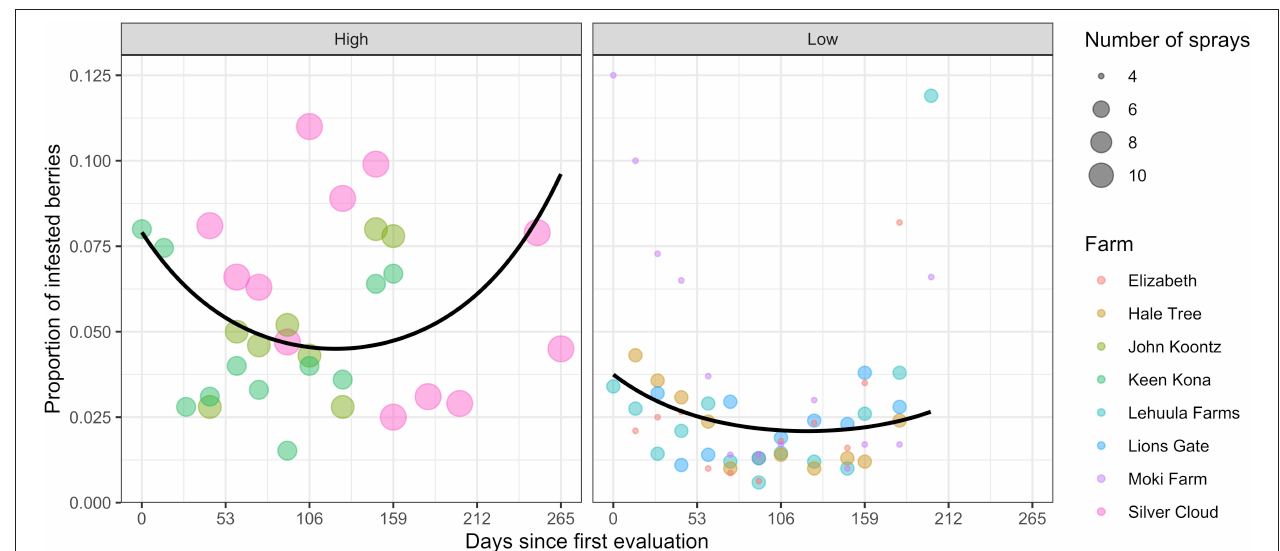
FIGURE 3 | Proportion of CBB-infested berries from eight coffee farms in the Kona and Ka’u districts of Hawaii adopting calendar (high) and threshold (low) spray programs. Data points represent one observation, and curves are fitted means from generalized binomial mixed models with linear and quadratic random effects over